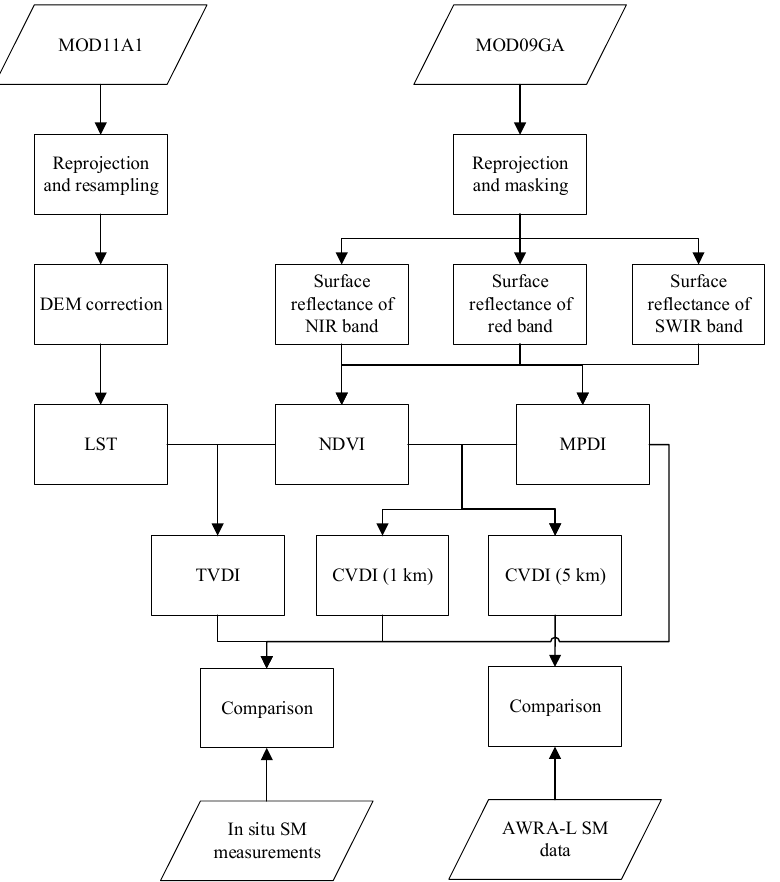
Figure 4. Flowchart of constructing CVDI and soil moisture (SM) monitoring in this